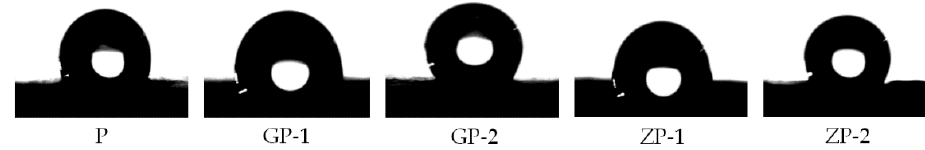
Figure 9. Water contact angle images of fabricated membranes.